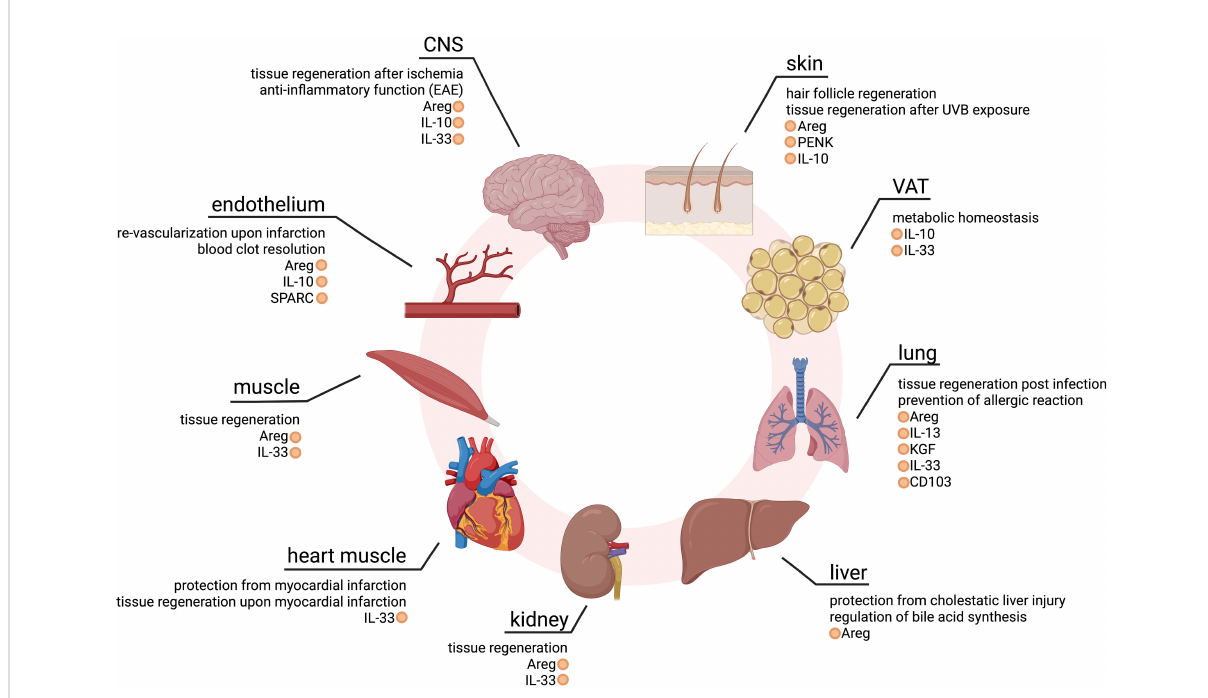
FIGURE 1 Overview of non-classical Treg cell functions in different tissues. Effector molecules mediating homeostatic or tissue-regenerative functions are marked in orange. CNS, central nervous system; VAT, visceral adipose tissue. Created with